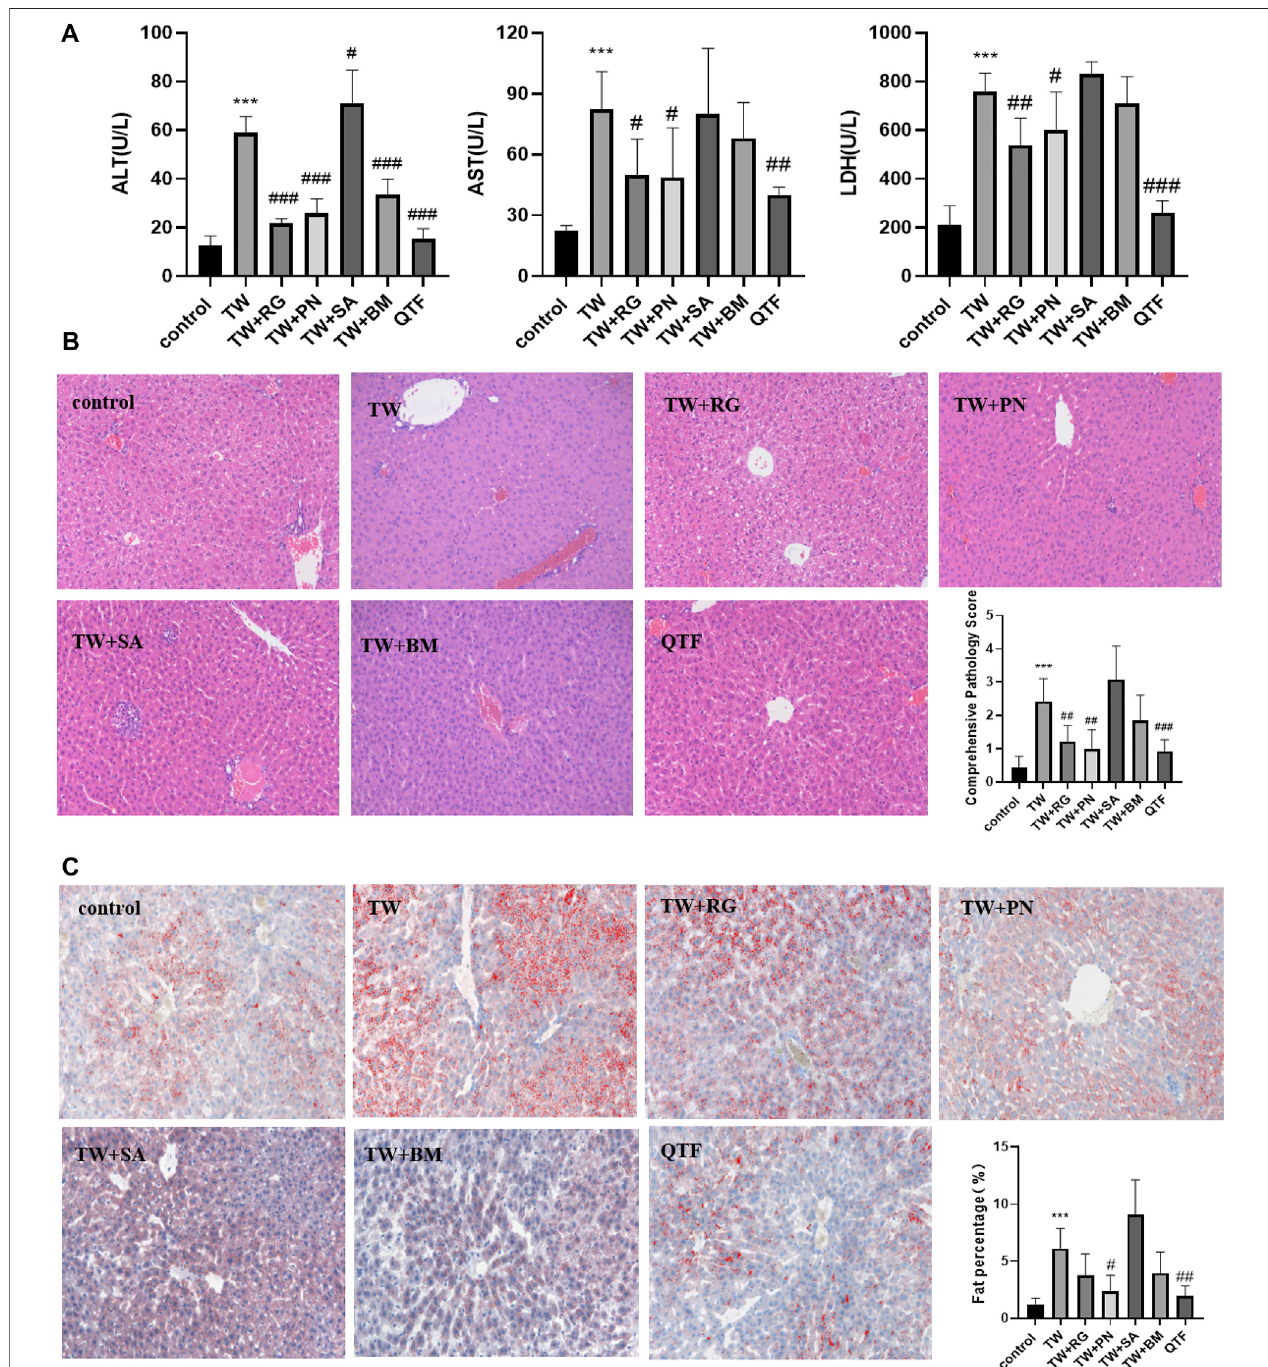
FIGURE 2 | QTF alleviated TW-induced hepatotoxicity in C57BL/6J mice. (A) QTF reduced the levels of ALT, AST and LDH caused by TW. (B) QTF reduced TW- induced pathological damage and comprehensive pathological score by H&E staining. (C) QTF reduced the fat accumulation and fat percentage by Oil red O staining. Compared with the control group, *p < 0.05, **p < 0.01, ***p < 0.001 ; compared with the TW group, # p < 0.05, ## p < 0.01, ### p <